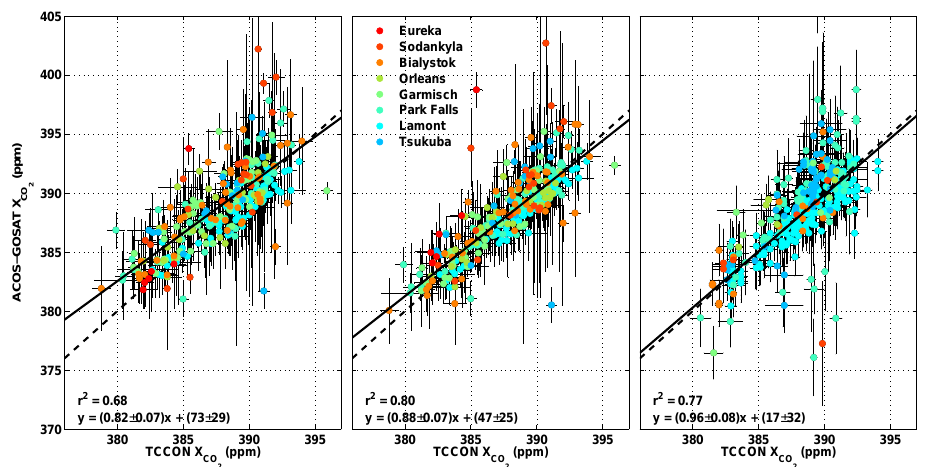
Fig. 17. The left two panels show the regression between TCCON and ACOS-GOSAT using the T 700 coincidence criterion (10 days, ± 10° latitude, ± 30° longitude and ± 2K). The left panel shows the large-scale bias-corrected, but otherwise unmodified, data. The middle panel shows the regression after applying Eq. (4). The right-hand panel shows the regression after applying Eq. (4), but using coincidence criteria that restricts latitudes to within ± 0 . 5 ◦ , longitudes to within ± 1 . 5 ◦ , and interpolates the TCCON data onto the ACOS-GOSAT measurement times. Note that there are no coincident data over Eureka when using the geographic coincidence criteria (right-hand panel). The solid lines show the best fit to the data (with equations and ± 2 standard errors shown on the plot), and the one-to-one line is plotted as a dashed line. The vertical bars represent the ± 2 σ variability of the ACOS-GOSAT data, illustrating the dependence of the variability of the ACOS-GOSAT data at each TCCON value (i.e., var( y | x )) in the regression. Similarly, the horizontal bars represent the ± 2 σ variability of the TCCON